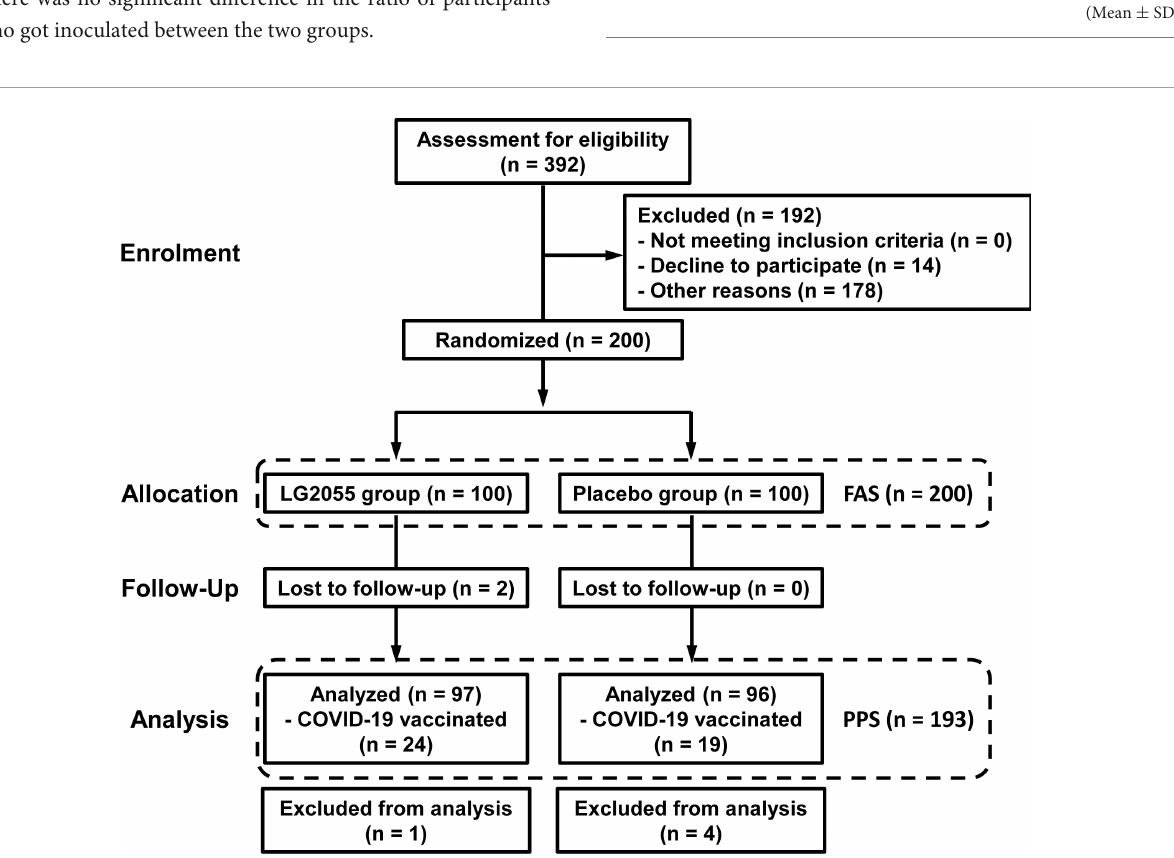
FIGURE2 Flow of participants through each stage of this study. For the participants who got COVID-19 vaccination during the pre-observation and intake periods, a part of the data of daily physical health questionnaire survey was